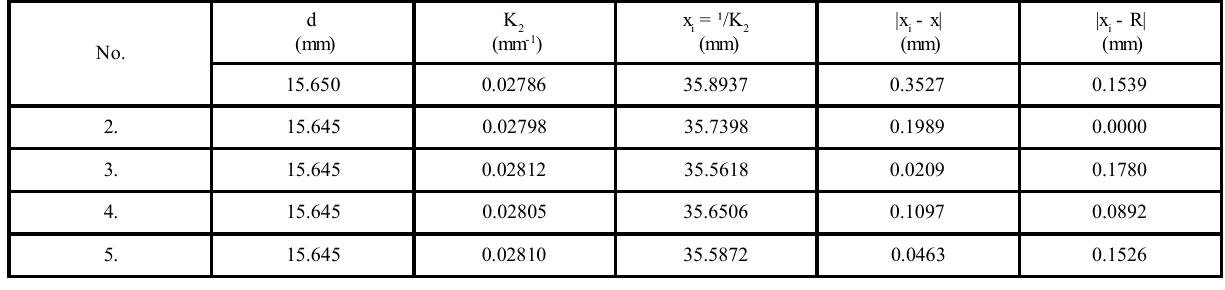
FIG. 9. BAR CHART OF COEFFICIENT OF CORRELATION AND STANDARD ERROR FOR SUBJECTS TABLE 5. ACCURACY AND PRECISION FOR CYLINDERICAL SUBJECTS